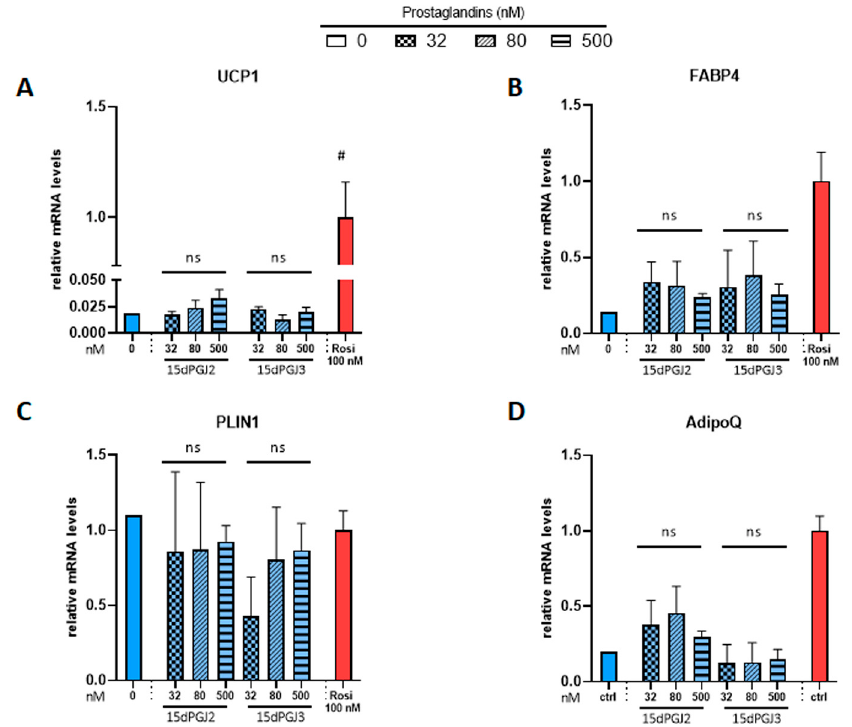
Figure 3. Potential PPAR γ activators, 15-deoxy-delta 12,14-PGJ2 and 15-deoxy-delta 12,14-PGJ3, don’t influence mRNA levels of PPAR γ target genes. White hMADS adipocytes (blue comumns) were induced to convert (from day 14 to day 18) into brite adipocytes (red columns) in the presence of various amounts of 15-deoxy-delta 12,14-PGJ2 (15dPGJ2) or 15-deoxy-delta 12,14-PGJ3 (15dPGJ3) using rosiglitazone (Rosi 100 nM) as positive control. mRNA levels of UCP1 ( A ), FABP4 ( B ), PLIN1 ( C ) and adiponectin ( D ) markers were measured. Histograms display mean ± SEM of two to eight independent experiments; Statistics were conducted through a one-way ANOVA with Dunett’s multiple comparisons test, where p < 0.05 was considered significant: #: p < 0.05, white control (0) vs. brite control (Rosi 100 nM) adipocyte. ns: not significant.